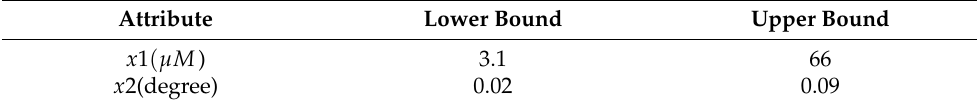
Table 11. The lower bound and upper bound of two attributes.